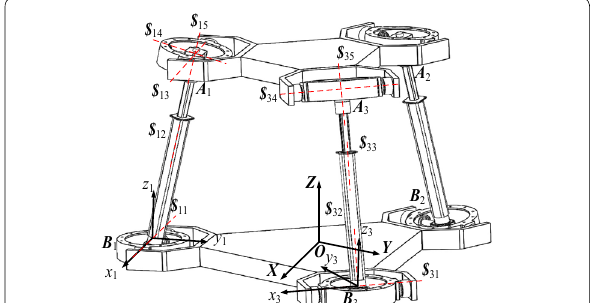
Figure 16. 2(rA-3) P(rA-3)-1(rA-6) P(rA-1)